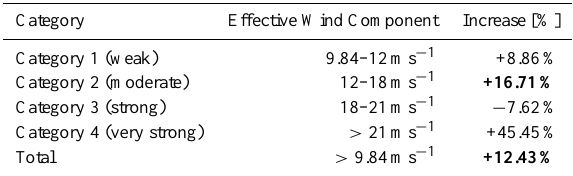
Table 2. Percental changes in the number of potential storm surge events of all three ensemble members during 2001–2100 (A1B) compared to the 1901–2000 (20C) for the four categories and all events. Statistically significant changes are highlighted.